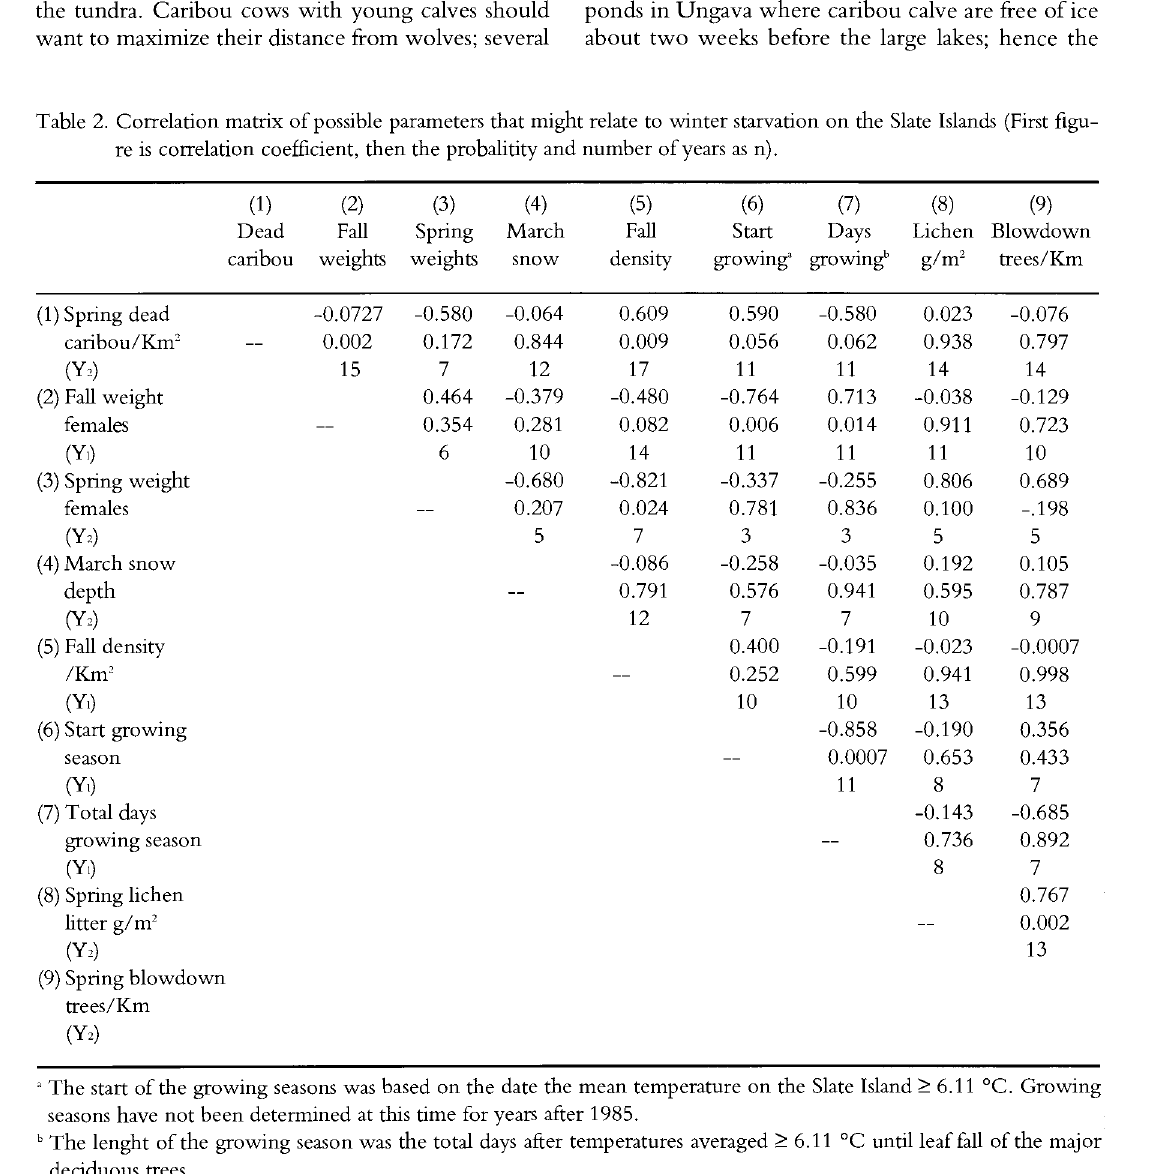
Table 2. Correlation matrix of possible parameters that might relate to winter starvation on the Slate Islands (First figu re is correlation coefficient, then the probalitity and number of years as